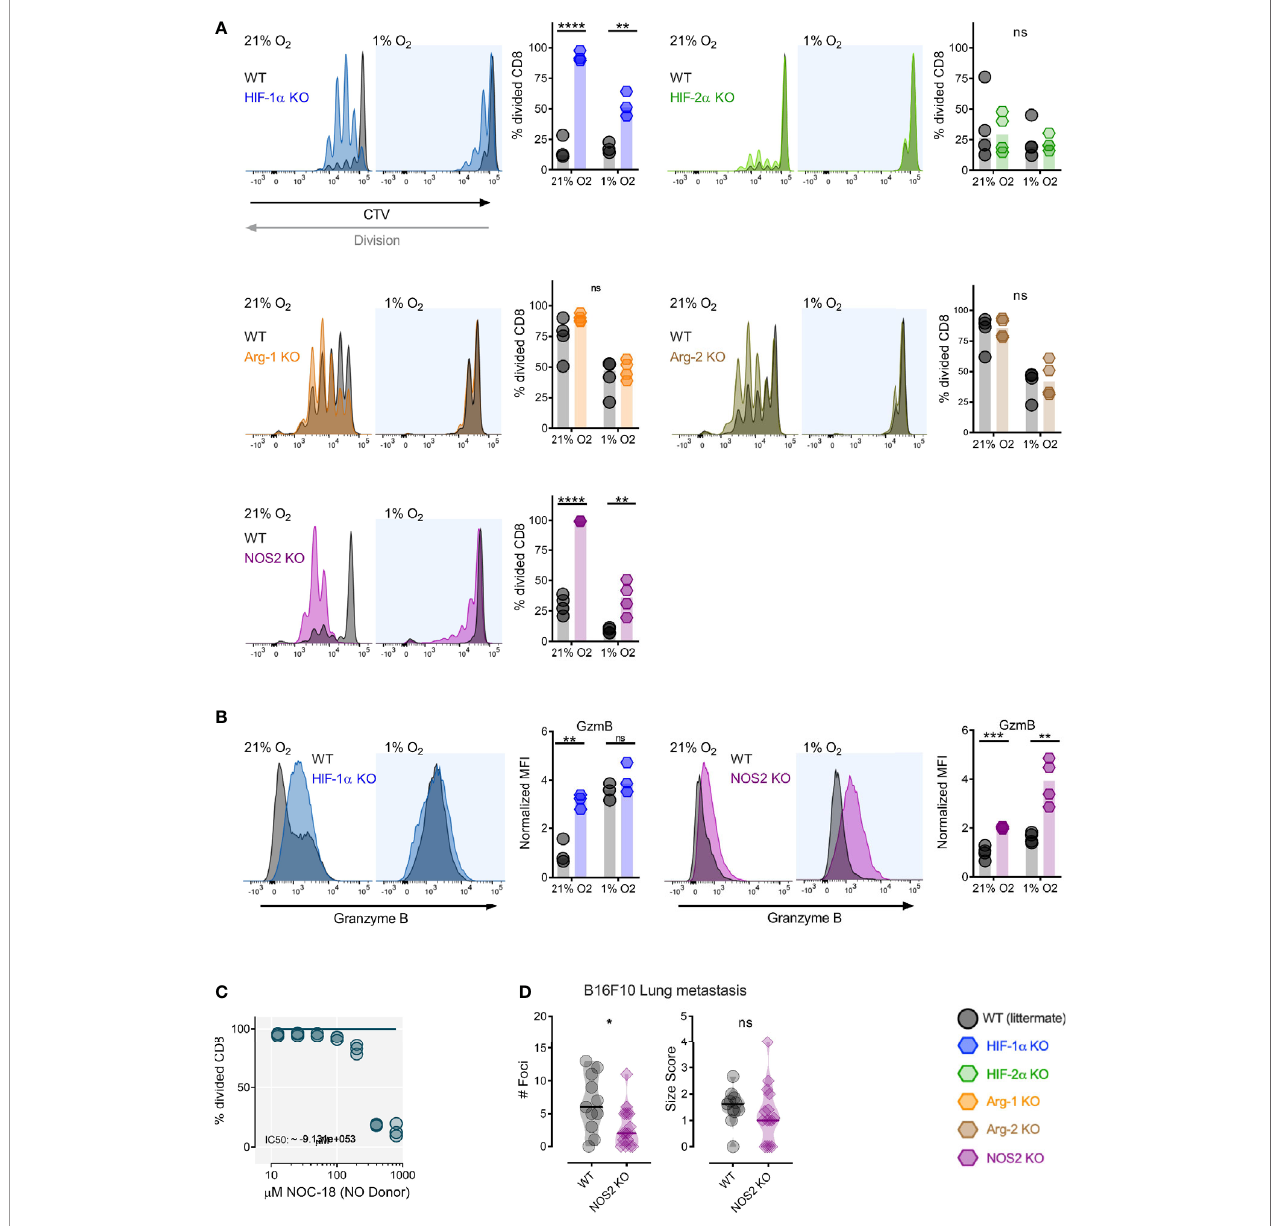
FIGURE 1 | Myeloid HIF-1 a inhibits antigen induced CD8 + T-cell division through NOS2. (A) Antigen presenting assay showing representative CTV histograms and division fraction of CD8 + T-Cells co-cultured with HIF-1 a fl / fl (WT) and HIF-1 a fl / fl LysM Cre+ (HIF-1 a KO), HIF-2 a fl / fl (WT) and HIF-2 a fl / fl LysM Cre+ (HIF-2 a KO), Arg-1 fl / fl (WT) and Arg-1 fl / fl LysM Cre+ (Arg-1 KO), Arg-2 fl / fl (WT) and Arg-2 fl / fl LysM Cre+ (Arg-2 KO), NOS2 fl / fl (WT) and NOS2 fl / fl LysM Cre+ (NOS2 KO) BMDMs in 21% or 1% oxygen. (B) Expression of Granzyme B as representative histograms and normalized MFI of CD8 + T-Cells activated by antigen presenting HIF-1 a fl / fl vs HIF-1 a fl / fl LysM Cre+ and NOS2 fl / fl vs NOS2 fl / fl LysM Cre+ BMDMs in 21% or 1% oxygen. (C) CD8 + T-cells activated for 72 hours in 5% O 2 and cultured for 2 days with increasing concentration of nitric oxide donor (NO) NOC-18. n=3 donors (D) 10-13 week old mice were injected intra venously with 0.2x10 6 B16-F10-OVA tumor cells. The mice were sacri fi ced 21 days post injection for collection of lungs. Number of foci and size score NOS2 fl / fl vs NOS2 fl / fl LysM Cre+ mice. Data presented as scatter dot plots or violin plots, *P < 0.05, **P < 0.01, ***P < 0.001, ****P < 0.0001; ns, not signi fi cant. Statistical analysis was performed with unpaired T test, n= 3-4 bone marrow donors (A, B) and n= 11-15 mice per group (D)